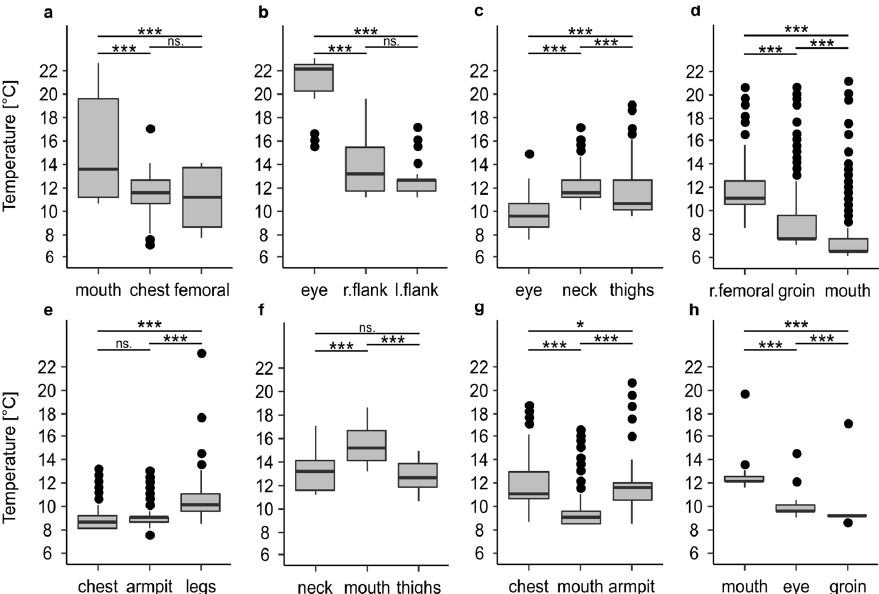
Figure 2. Temperature differences between the maggot masses on bodies stored in a walk-in cooler. Information on the period of temperature measurement and the entire cooling period are given in Table 1. The temperature profiles belong to corpse 1 ( a ), corpse 2 ( b ), corpse 3 ( c ), corpse 4 ( d ), corpse 5 ( e ), corpse 6 ( f ), corpse 7 ( g ), and corpse 8 ( h ). The asterisks representing p -values with *** < 0.001, ** < 0.01, * < 0.05, n.s not significant.